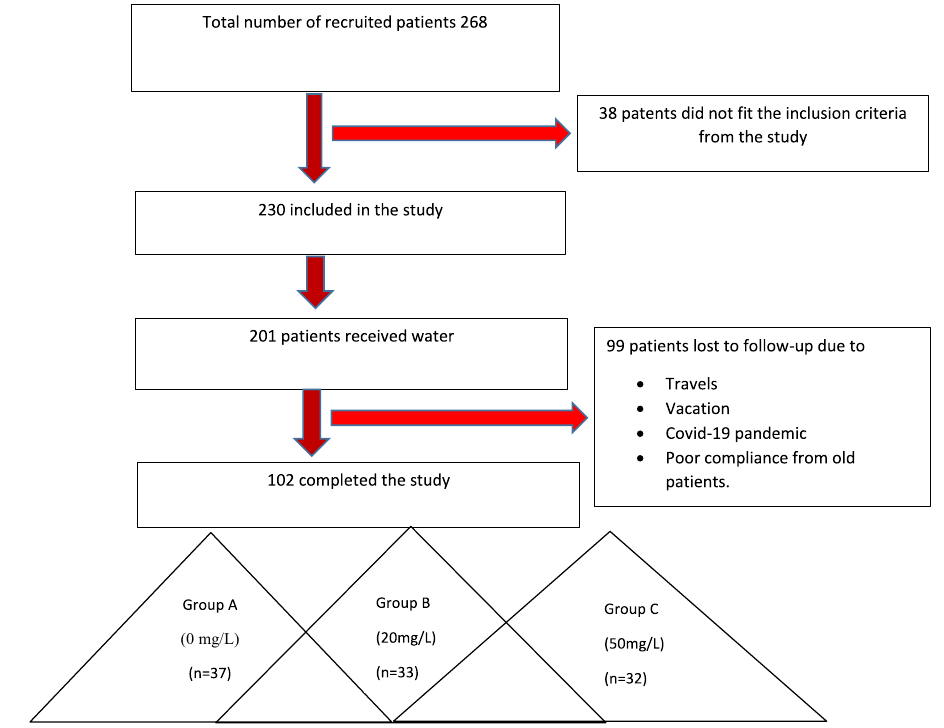
Fig. 1 Study fl ow diagram. The total number of 102 diabetic patients were randomly allocated into Group A ( n = 37) received bottled water without added magnesium; Group B ( n = 33) received bottled water with a low level of magnesium (20 mg/L); Group C ( n = 32) received drinking water with a high level of magnesium (50